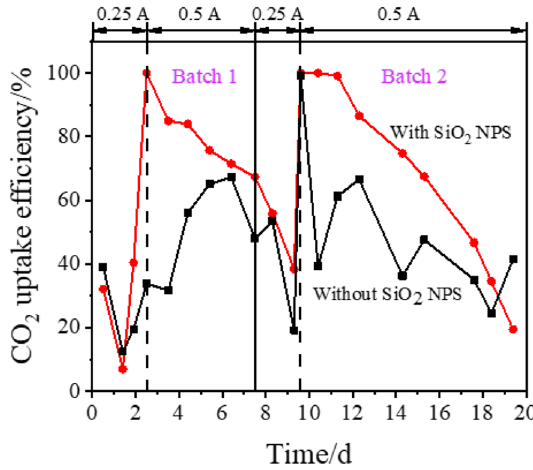
Fig. 6 CO 2 uptake efficiency of the MES reactor in two batches. At 0.25 A and 0.5 A, the CO 2 flow rates were 1.96 mL 3.92 mL min − 1 , ·